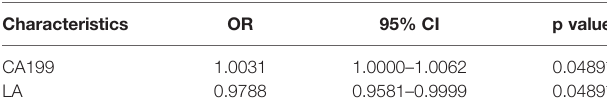
TABLE 3 | Multivariate analysis of risk factors associated with MCNs.